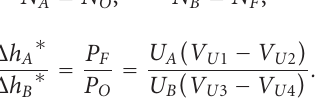
Figure 2: Influence of work ratio on HP e ffi ciency.